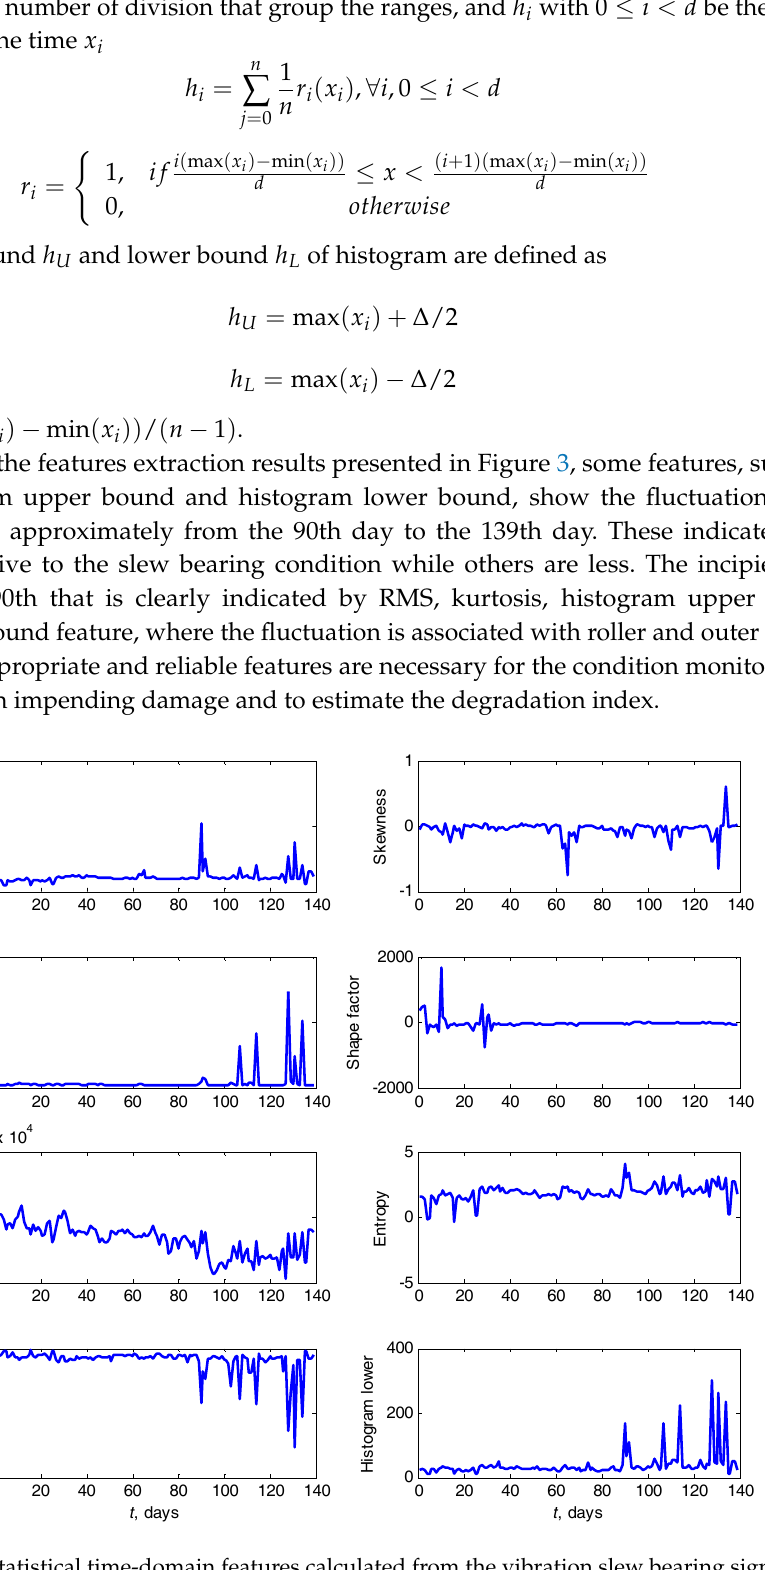
Figure 3. Statistical time-domain features calculated from the vibration slew bearing signal.